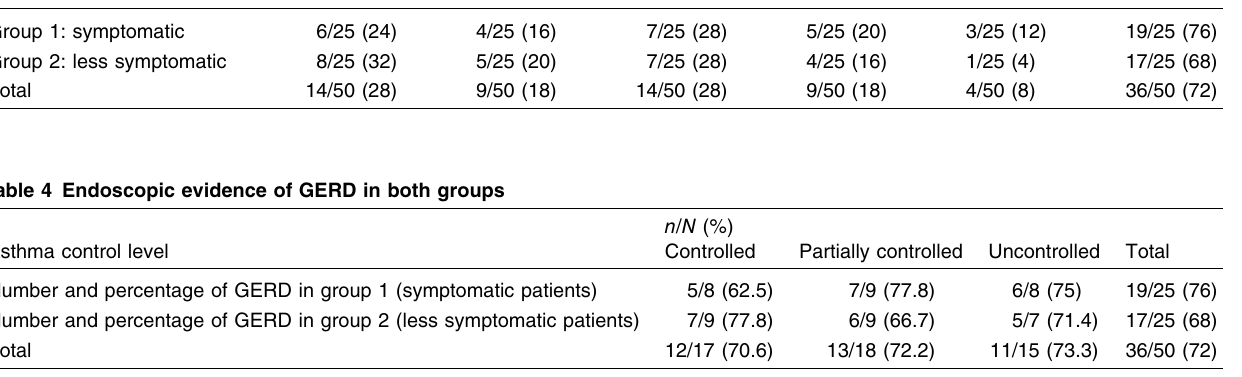
Table 3 Severity of GERD as detected by upper GI endoscopy in both groups n / N (%) No GERD Grade A Grade B Total Group 1: symptomatic Group 2: less symptomatic